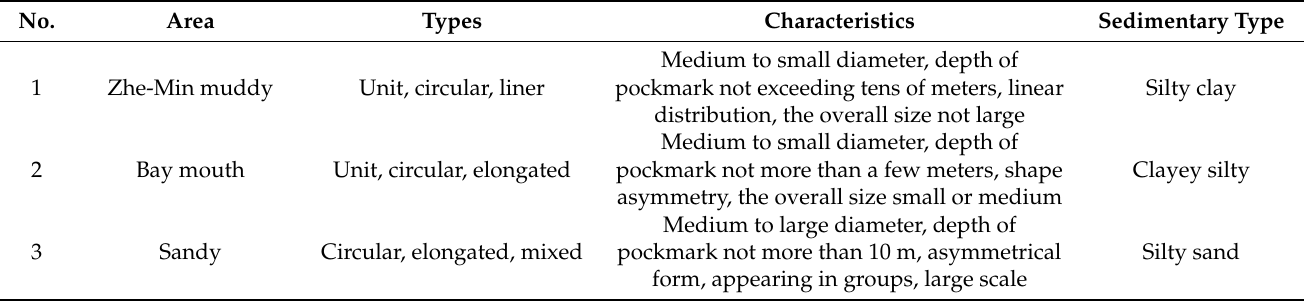
Table 2. Distribution and types of pockmarks in the study area.